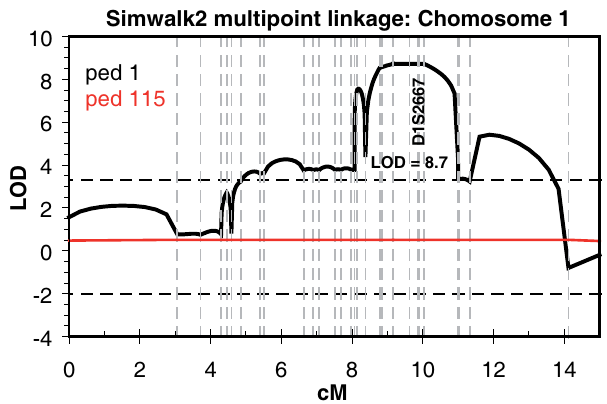
Figure 3. Multipoint linkage analysis using Simwalk for Family F105 (ped 1 in the figure) and F115 (ped 115 in the figure), across the linked chromosomal interval. In this analysis individual 1443 of family 105 was set as phenotype unaffected; the maxLOD increased slightly to 9.5 when 1443 was set to phenotype unknown. A maxLOD=6.6 was obtained using an affecteds-only model.